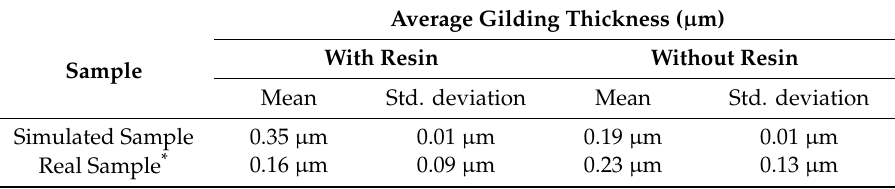
Table 1. Average golf leaf thickness calculated over AoIs B (with resin) and C (without resin).